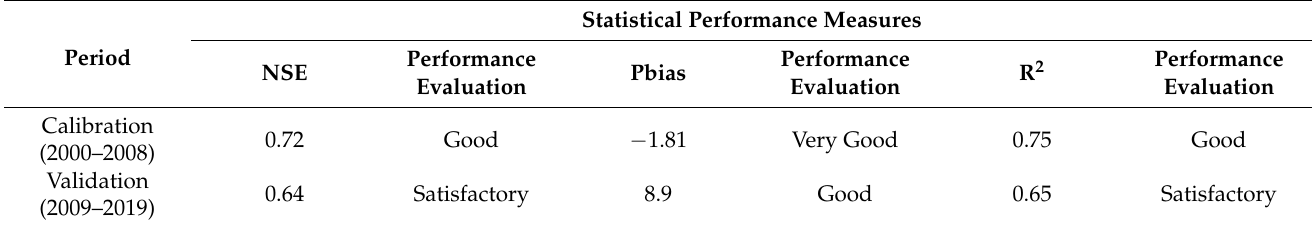
Table 4. Model performance for streamflow on a daily basis.